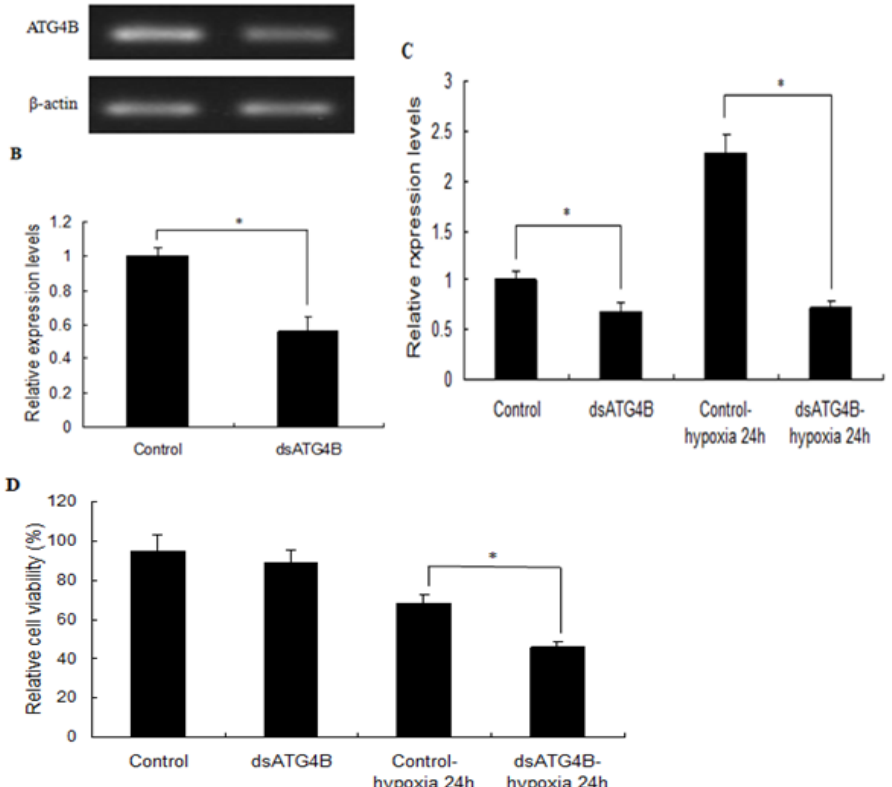
Figure 7. RNA interference (RNAi)-based functional analysis of ATG4B in M. nipponense . RNAi efficiency of ATG4B silencing compared with enhanced green fluorescent protein (eGFP) at 4 days post-dsRNA injection was analyzed by semi-quantitative PCR ( A ) and qRT-PCR ( B ). ATG8 mRNA expression levels ( C ) and cell viability ( D ) in M. nipponense juvenile brains after dsRNA injection were analyzed under hypoxia and normoxia conditions. Results were normalized against β -actin as an internal transcription reference. Data are presented as mean ± SE of three independent biological replicates.